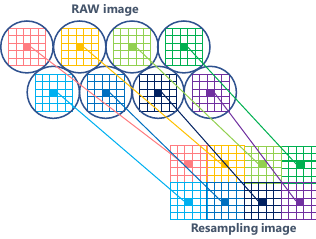
Figure 6. Resampling from raw image